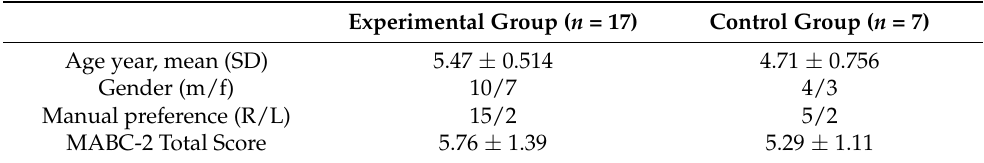
Table 1. Experimental and control groups. Characteristics of participants by age (years), sex (male; female), manual preference (right; left), and MABC-2 pre-test